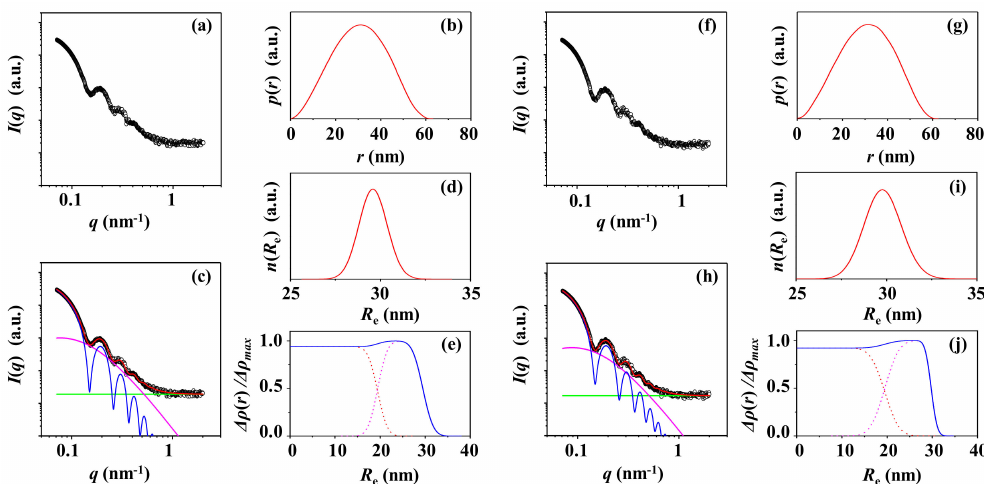
Figure 4. X-ray scattering data analysis of PS-2 particle. ( a ) SAXS profile measured at room temperature and corrected for water as the solution medium: ( b ) pair distance distribution functions p ( r ) obtained from the scattering profile using the IFT method; ( c ) data analysis results; ( d ) radius distribution obtained by the data analysis in ( c ); ( e ) density distribution obtained by the data analysis in ( c ). ( f ) SAXS profile measured at room temperature and corrected for the supernatant as a solution medium: ( g ) pair distance distribution functions p ( r ) obtained from the scattering profile using the IFT method; ( h ) data analysis results; ( i ) radius distribution obtained by the data analysis in ( h ); ( j ) density distribution obtained by the data analysis in ( h ). ( c , h ) the open symbols are the measured data and the red solid line represents the sum of the profiles obtained by fitting the data using two-phase ellipsoid model (blue line) and local random two-phase contributions (purple line) and the background (green line).